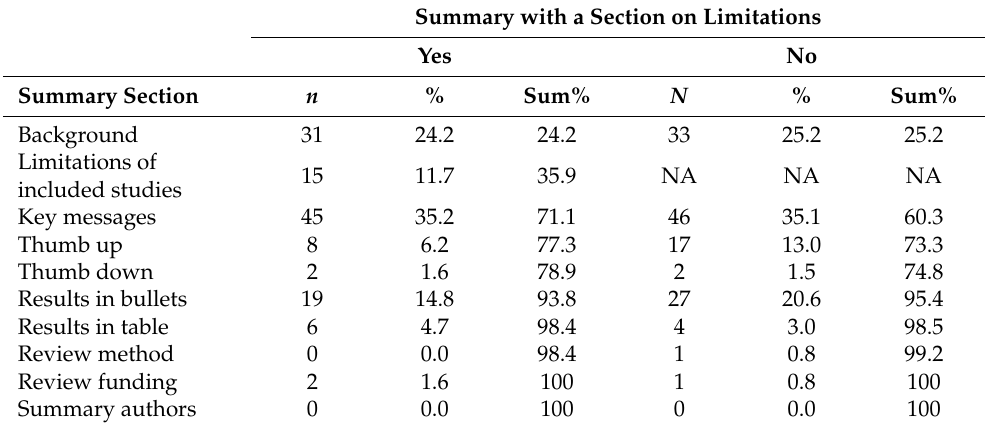
Table 6. Most helpful summary section for summary including information about